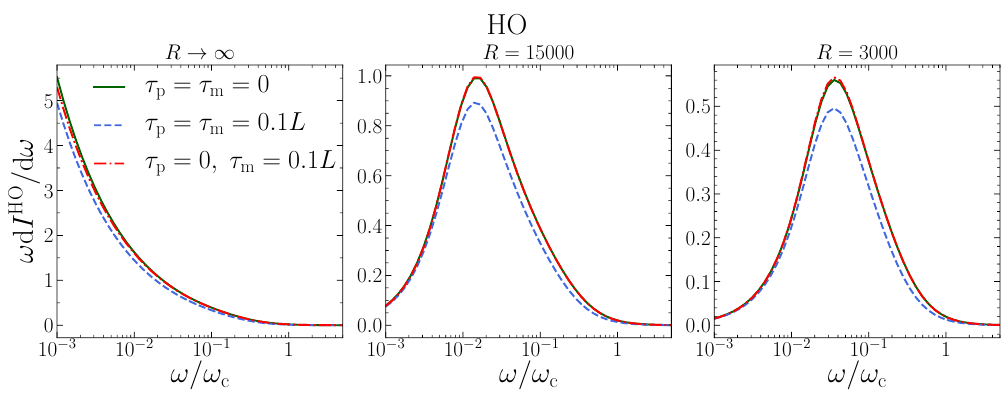
Figure 6 . HO medium-induced energy spectrum as a function of ω/ω c for the three scenarios analyzed in this paper: τ p = τ m = 0 (green solid lines); τ p = τ m = 0 . 1 L (blue dashed lines); and τ p = 0 and τ m = 0 . 1 L (red dash-dotted lines). The different panels correspond to different sets of R : R → ∞ (left), R = 15000 (central), and R = 3000 (right). which for | Ω τ | (cid:28) 1 m